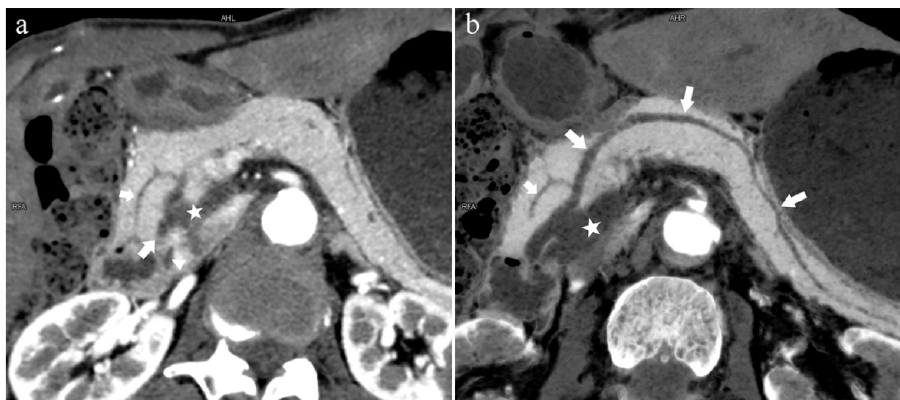
Figure 5. Type 1. A 68-year-old male patient with IPMN. ( a ): MIP [45keV MEI(+)] shows a tumor (pentagram) and the dilated MPD (long arrow) in the head of the pancreas. APD (short arrow) drained from MiP and communicated with MPD. The common bile duct (arrow) is clearly visible. Postoperative pathology confirmed that the mass was IPMN. ( b ): MinIP [45keV MEI(+)] clearly shows the overall direction of MPD.